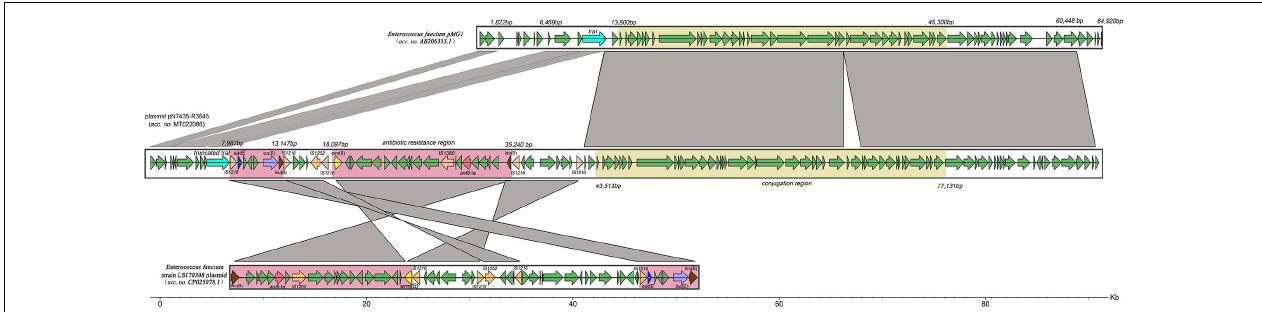
FIGURE 3 | Structure of the lsa (E)-carrying plasmid pN7435-R3645 and similar regions in plasmid pMG1 and plasmid LS170308 of E. faecium . The structure of the plasmid pN7435-R3645 is illustrated based on the nucleotide sequences deposited in the GenBank database (MT022086). ORFs are indicated by arrows coloured as follows: orange, insertion sequences; purple, lsa (E); blue, aadE ; pink, ant6 -Ia; brown, lnu (B); yellow, erm (B); light blue, traI or truncated traI ; and green, other genes. The similarities in the structures are indicated by grey shading. Antibiotic resistance regions and conjugation regions are shown in pink and yellow,